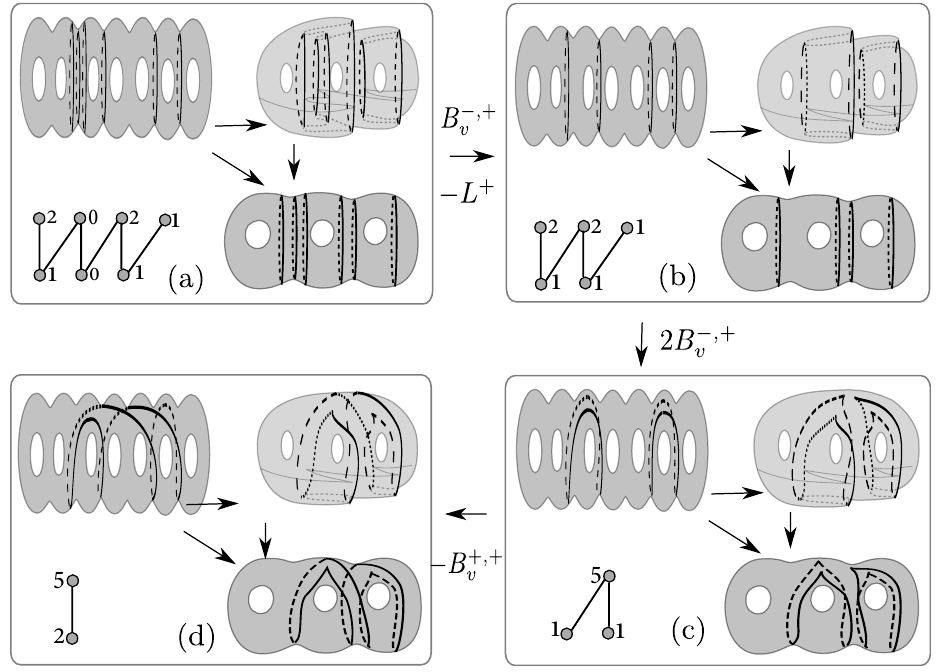
Figure 11. Examples of transitions B ± , + v and S .